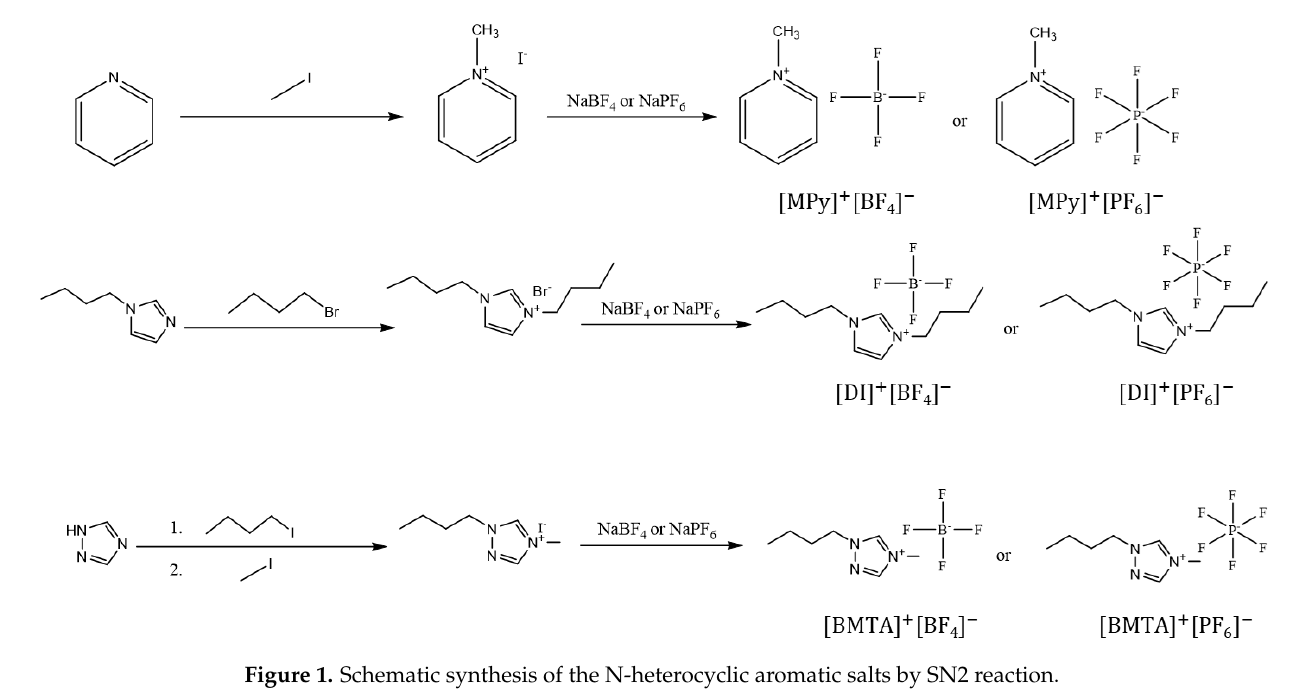
Figure 1. Schematic synthesis of the N-heterocyclic aromatic salts by SN2 reaction.